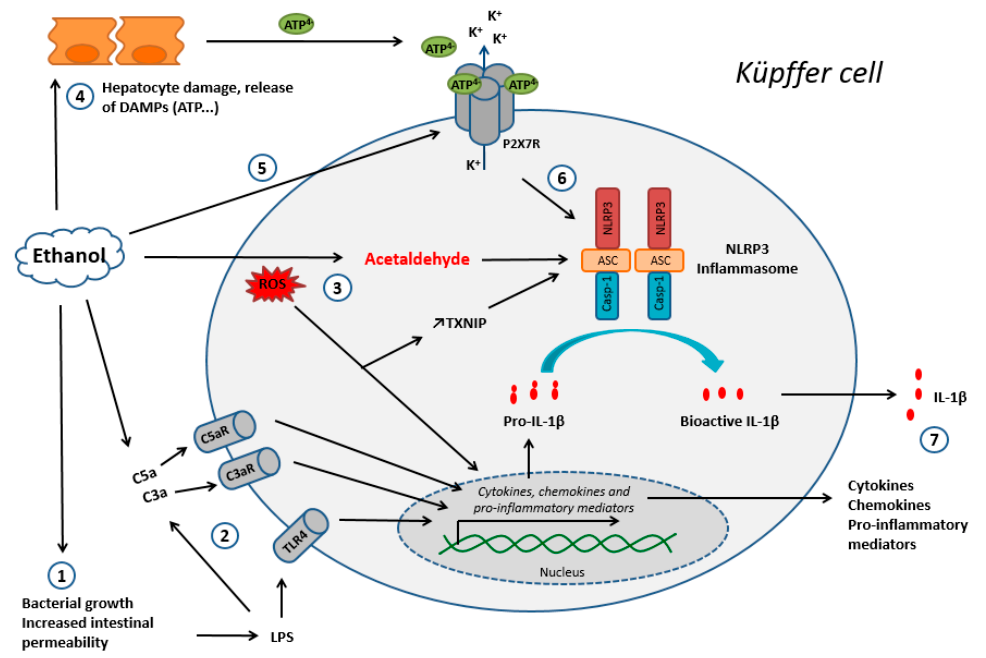
Figure 4. The main mechanisms of Kupffer cell activation during chronic ethanol exposure. Step 1: An increase in intestinal permeability, leading to the release of LPS into the systemic circulation and activation of the TLR4 receptor. Step 2: Activation of the complement system, in particular via LPS. Steps 1 and 2 lead to the production of chemokines, cytokines, and other pro-inflammatory mediators. Step 3: Oxidative metabolism of ethanol; ROS and acetaldehyde lead to an increase in TXNIP expression, activation of the NLRP3 inflammasome, and the production of pro-inflammatory cytokines (ii). Step 4: Hepatocyte damage due to the oxidative metabolism of ethanol results in the release of danger signals, including ATP. Step 5: Ethanol induces the expression of P2X7R, further sensitizing the cell to danger signals like ATP. Step 6: ATP activates the NLRP3 inflammasome via purinergic receptors. Step 7: Release of the chemokines, cytokines, and inflammatory mediators produced upstream. Abbreviations: DAMP: danger-associated molecular pattern; LPS: lipopolysaccharides; ROS: reactive oxygen species; TXNIP: thioredoxin interacting protein.